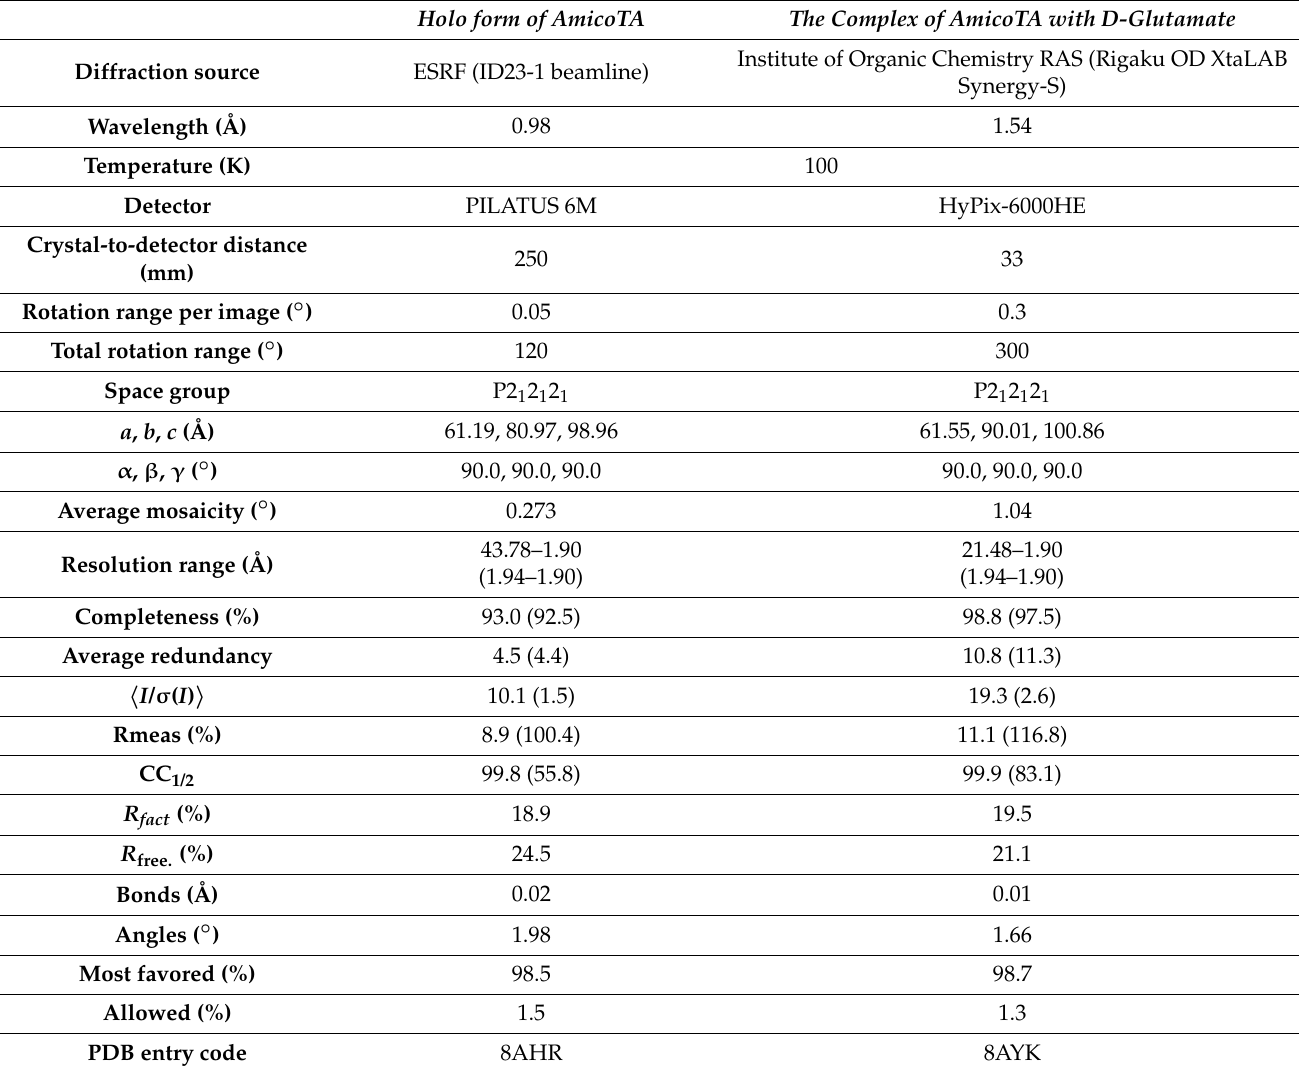
Table 5. Data collection and refinement statistics. Holo form of